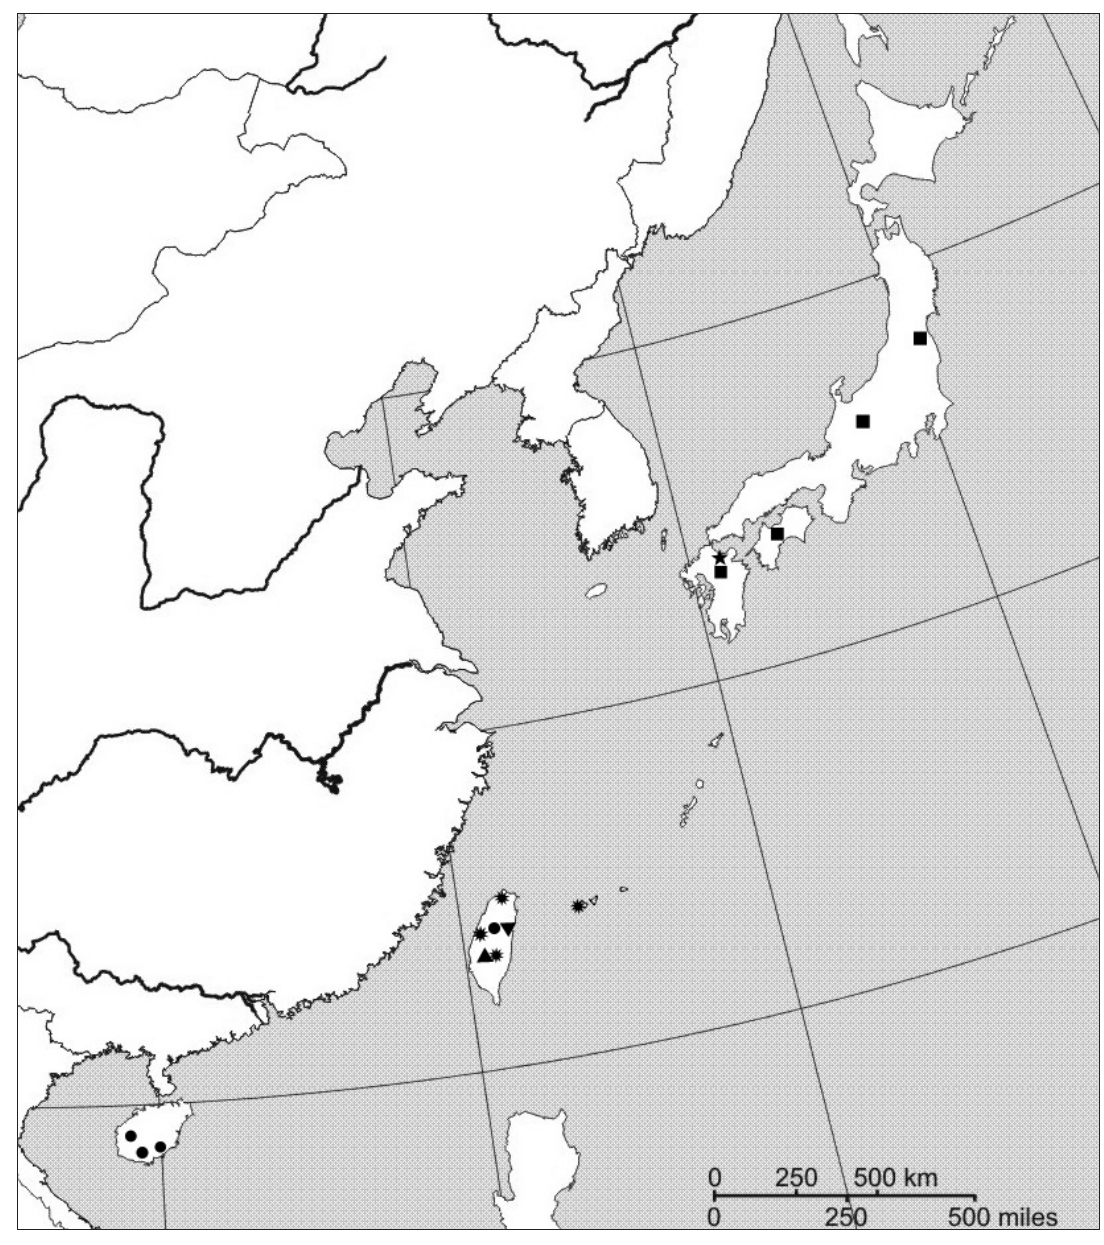
Figure 32. Geographic distribution of the species of Dilar . ▲ Dilar formosanus (Okamoto & Kuwayama);  Dilar hikosanus Nakahara; ● D. insularis sp. n.; ■ Dilar japonicus McLachlan; ▼ Dilar pallidus Nakahara;  Dilar taiwanensis